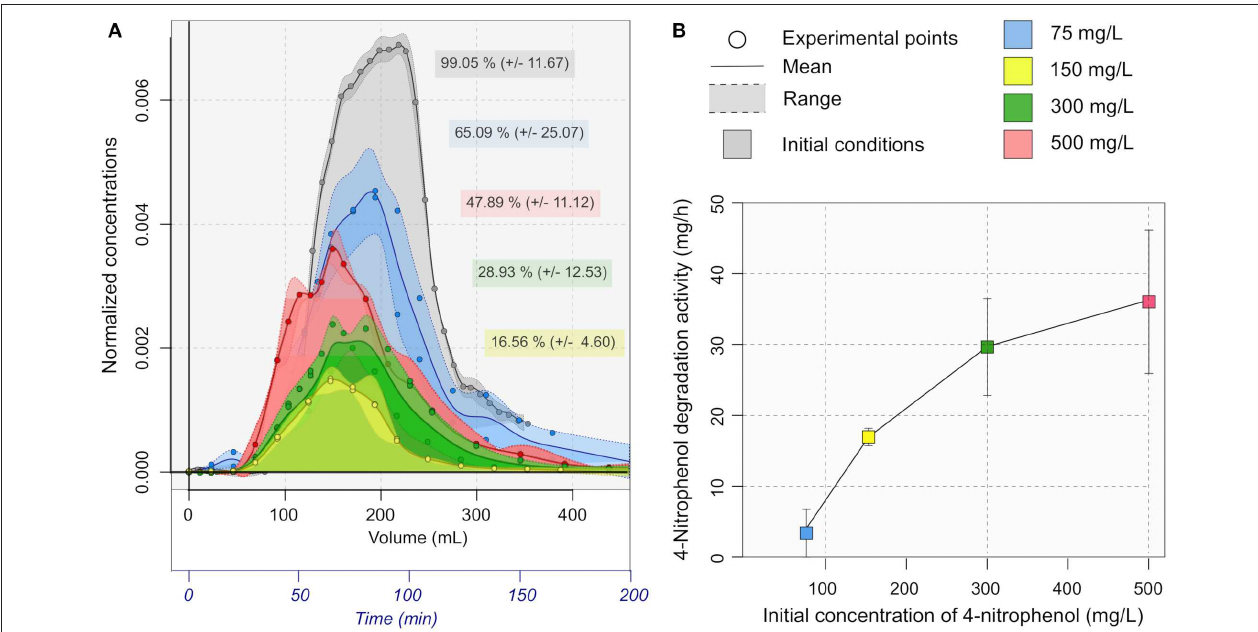
FIGURE 5 | (A) Residence time distribution of 4-NP. The normalized concentrations were expressed as a function of the Time and the cumulative volume in the outlet. The area represents the percentage of 4-NP quantity recovered in the outlet. (B) 4-NP degradation rate in mg/h calculated from the residence time distribution.